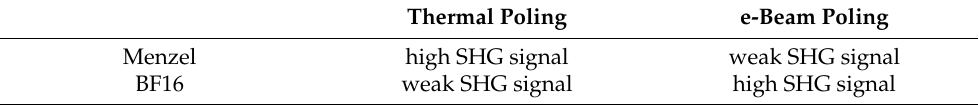
Table 2. SHG signal from Menzel and BF16 glass slides poled under selected